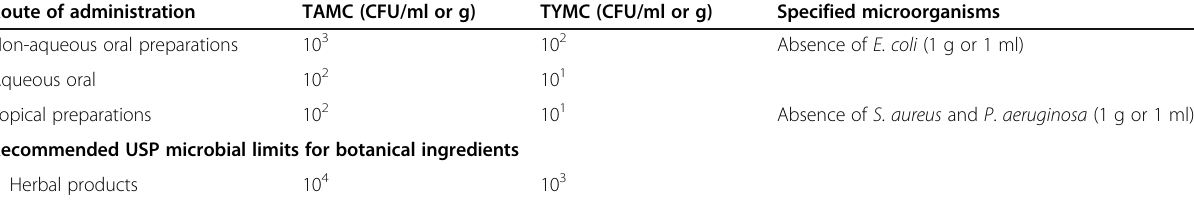
Table 2 Acceptance criteria for microorganism ’ s enumeration tests of non-sterile pharmaceutical products according to USP Route of